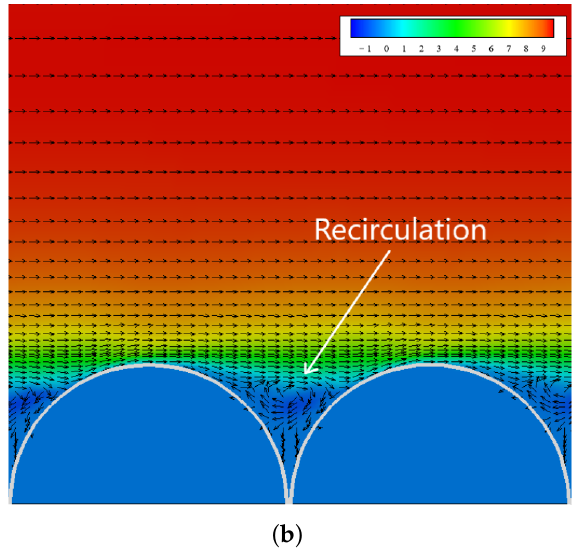
Figure 6. Iso-surface (cid:104) U (cid:105) = − 0.1 of the time-averaged streamwise velocity ( a ) and their contours in the ‘x-y’ cross-section ( b ) in the configuration S2.0o.